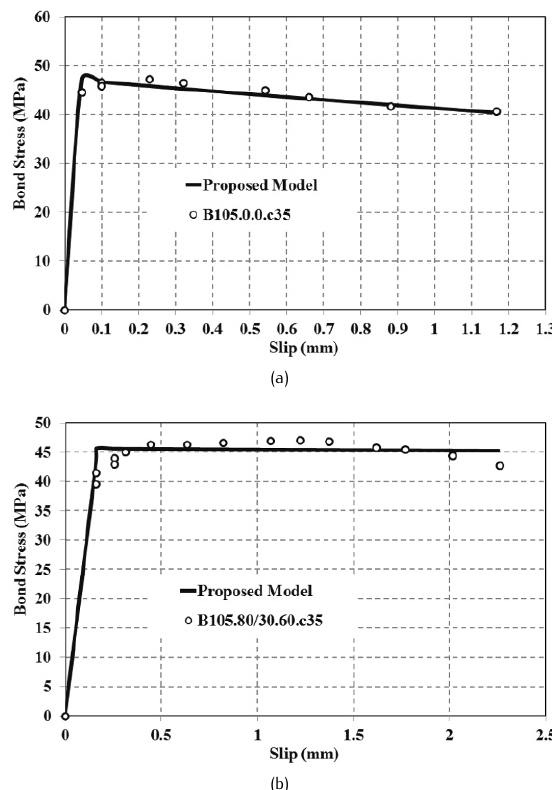
Figure 16. Comparison of the experimentally obtained load-slip curves (Schumacher [30]) versus the predicted curves by using the proposed model for (a) f 0 c = 45 , without fiber and concrete cover = 95 and (b) f 0 c = 45 , with fiber “aspect ratio: 80/30” and “fiber content: 60 (kg/m 3 )”, and concrete cover = 95.